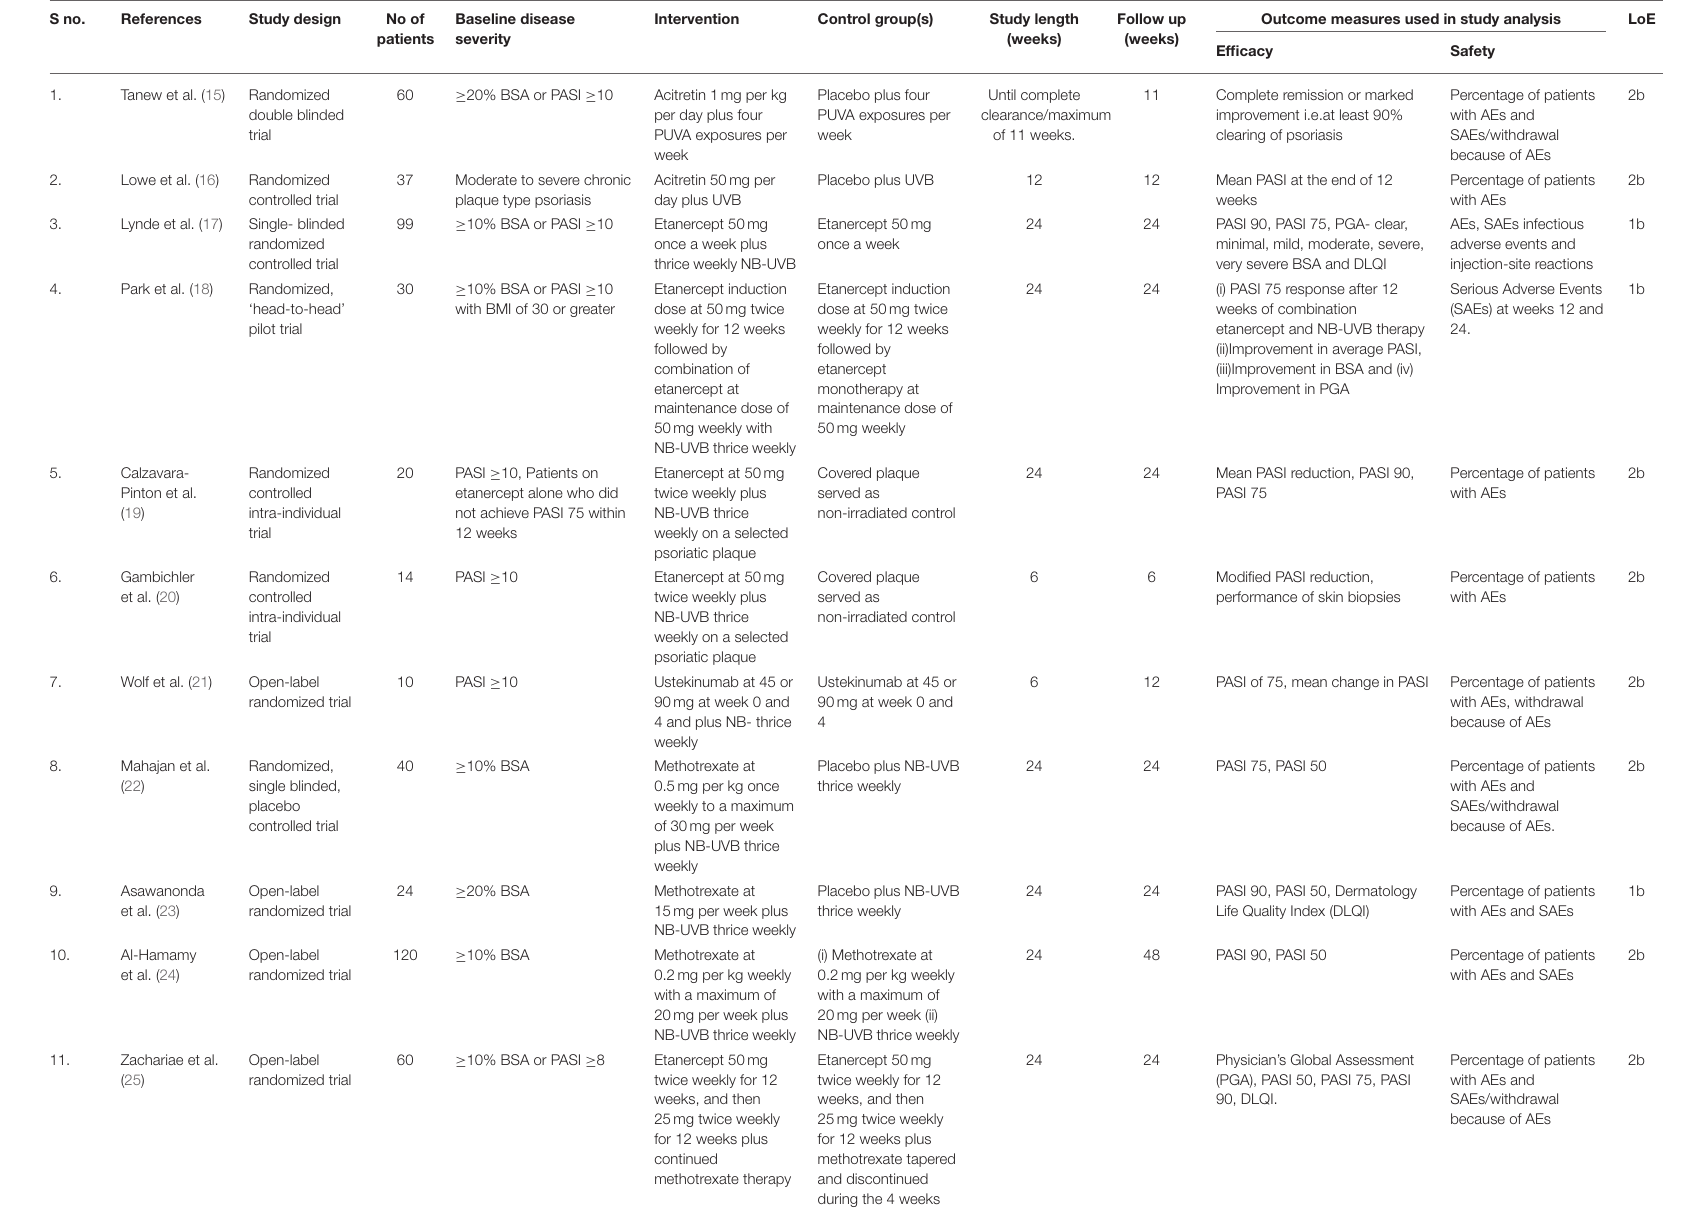
TABLE 1 | Randomized controlled trials which met the inclusion criteria and selected in this study ( n = 25). S